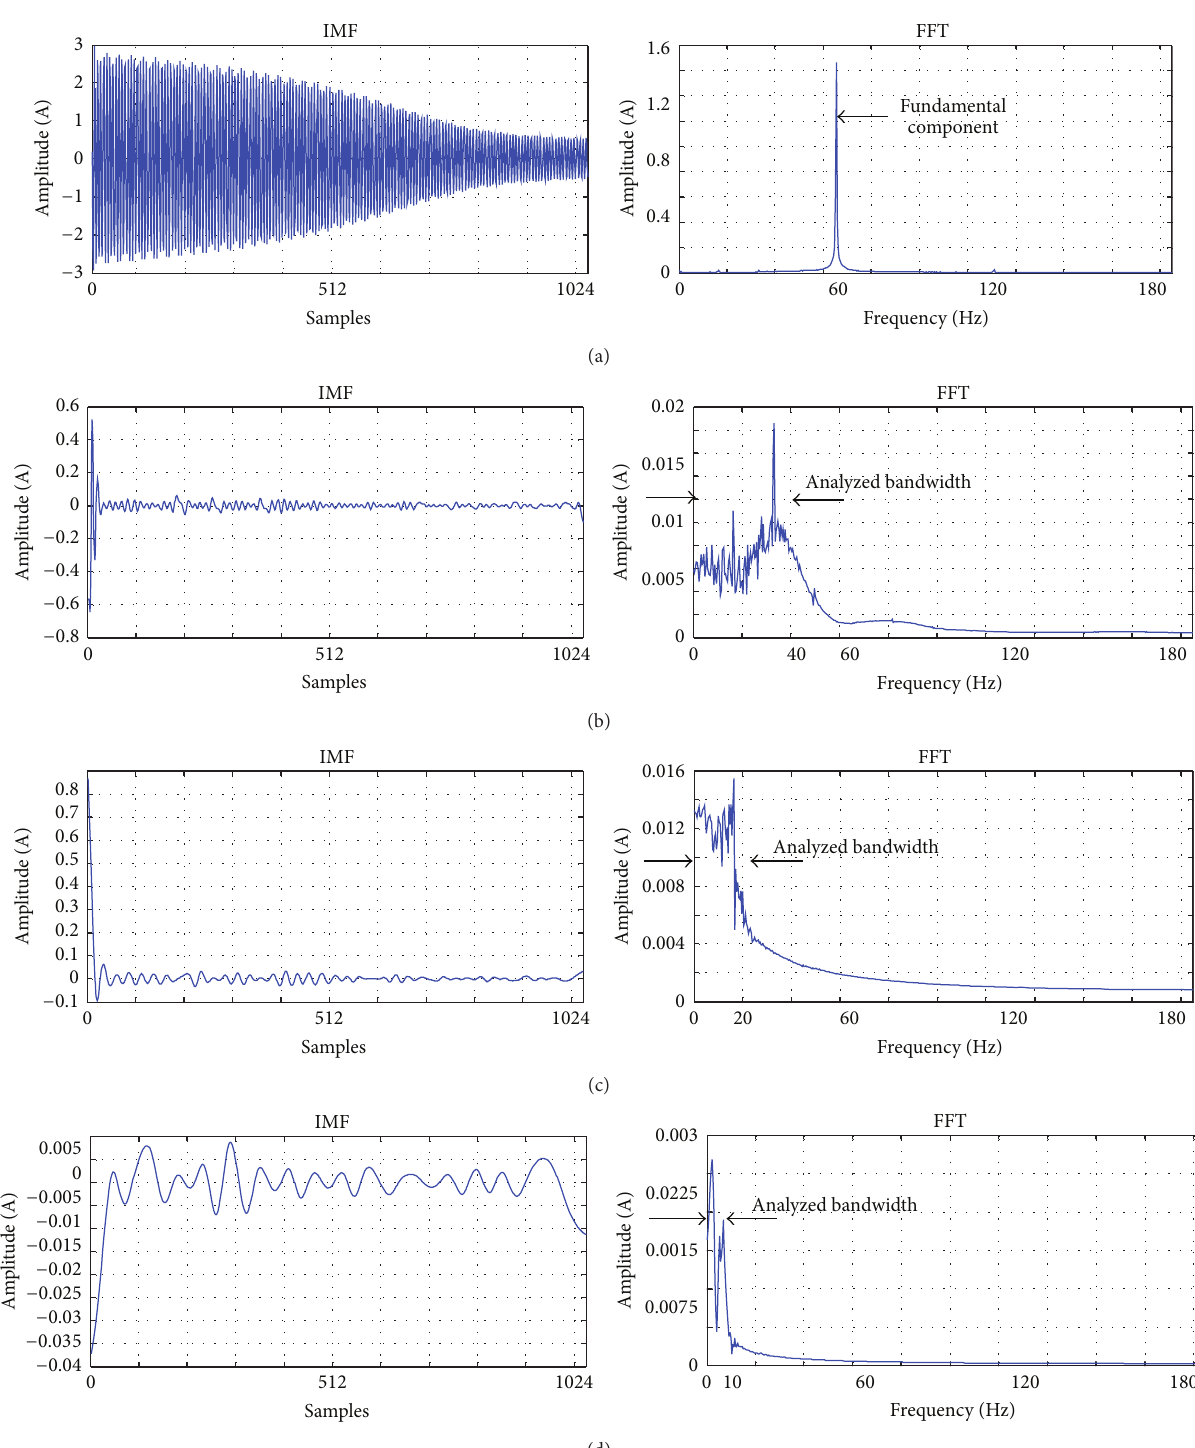
Figure 7: Frequency content for each IMF of a HLT induction motor: (a) first IMF, (b) second IMF, (c) third IMF, and (d) fourth